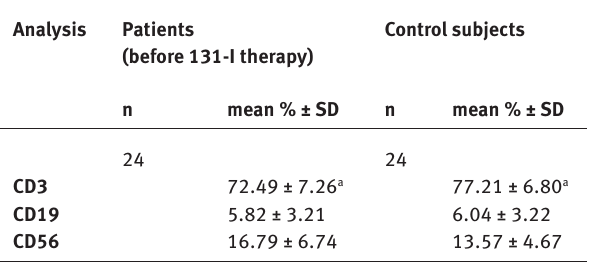
Table 3: CD3, CD19 and CD56 expression in peripheral blood lym- phocytes of DTC patients before 131-I therapy and healthy controls